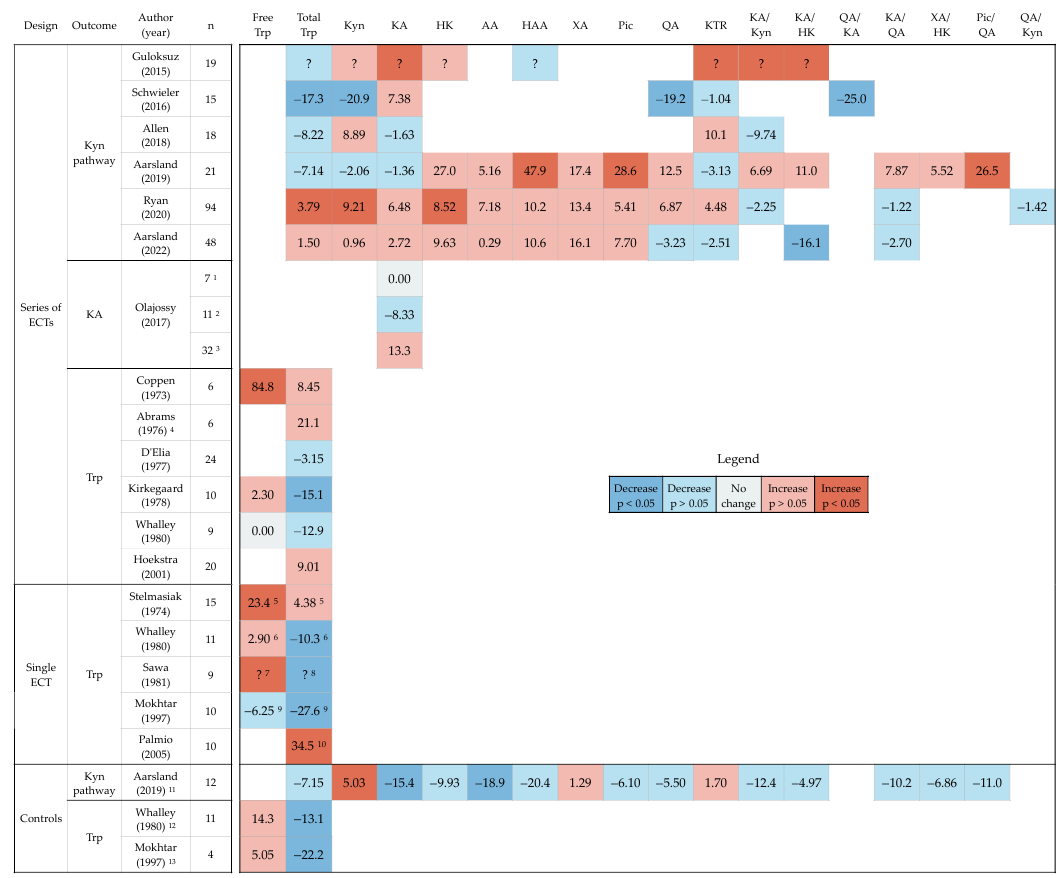
Figure 5. Percentage change in tryptophan, kynurenines and ratios after ECT. Percentage change was calculated based on concentrations before and after ECT collected from the included studies, except for Ryan (2020) [37] and Aarsland (2022) [64], where changes in percentage were collected from the reports. See Supplementary Table S1 for a detailed overview of the collected outcomes from each of the reviewed studies. The question marks indicate that the size of change was unknown due to missing data on concentrations. Comments on participant diagnosis, sample type, and sample timing: 1 schizoaffective disorder, 2 depression in bipolar disorder, 3 recurrent depressive disorder; 4 cerebrospinal fluid samples; samples collected 5 15 min after ECT, 6 10 min after first ECT, 7 1 min after ECT, 8 5 min after ECT, 9 60 min after ECT, 10 2 h after ECT, 11 with eight weeks between, 12 after recovery from anesthesia, and 13 15 min after start of surgery. Abbreviations: AA, anthranilic acid; ECT, electroconvulsive therapy; HAA, 3-hydroxyanthranilic acid; HK, 3-hydroxykynurenine; KA, kynurenic acid; KTR, kynurenine-tryptophan-ratio; Kyn, kynurenine; Pic, picolinic acid; QA, quinolinic acid; Trp, tryptophan; XA, xanthurenic acid. References: Guloksuz (2015) [33], Schwieler (2016) [34], Allen (2018) [36], Aarsland (2019) [35], Ryan (2020) [37], Aarsland